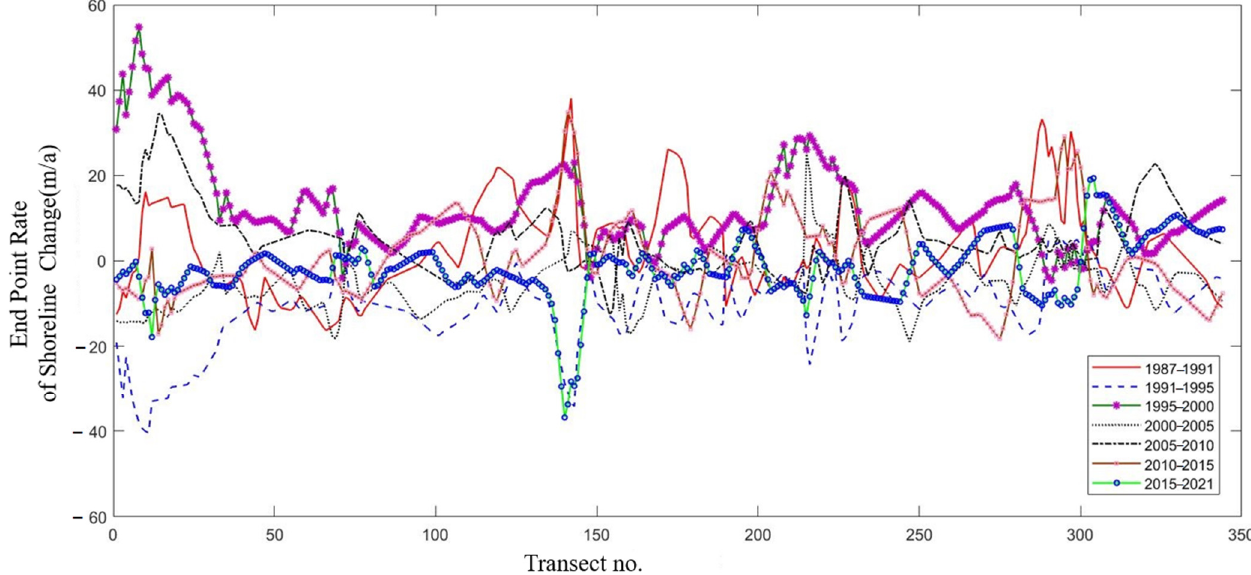
Figure 8. The EPR of each transect in different periods. To evenly study the conditions of coastline evolution during a certain medium-term period (about 3–5 years), seven periods were created based on the acquired coastlines from 15 periods between 1987 and 2021.